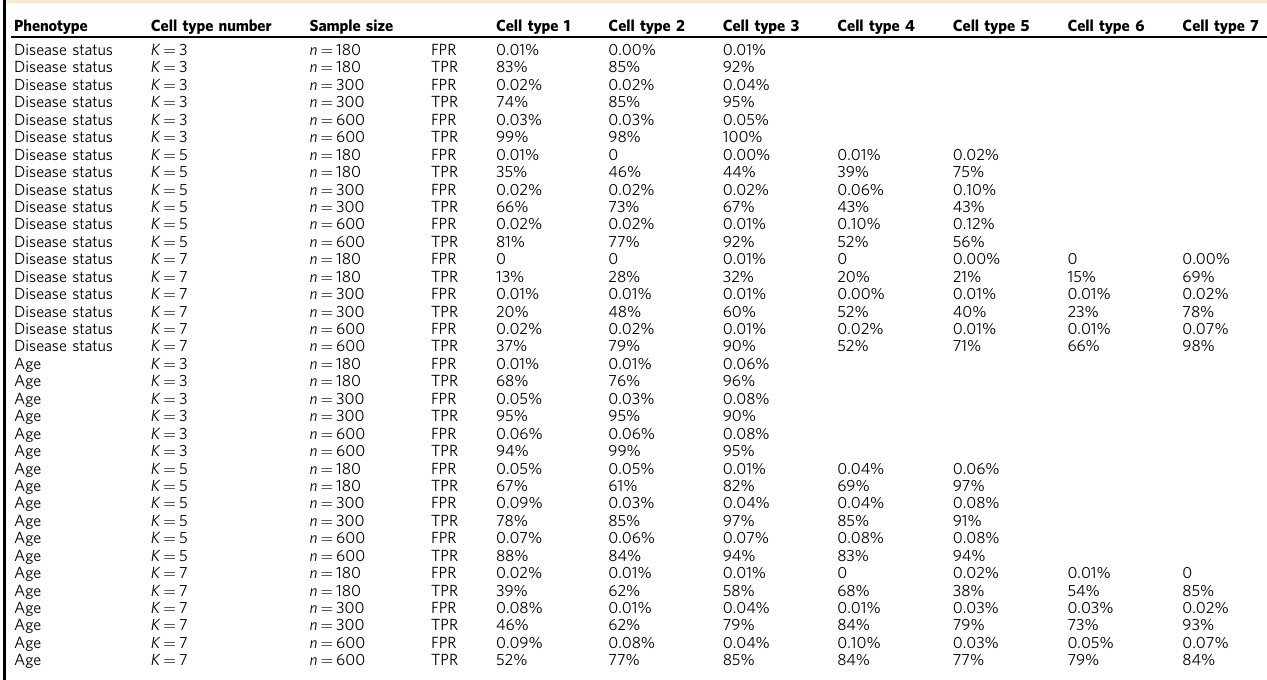
Table 2 Performance of HIRE in detecting cell-type-speci fi c risk-CpG